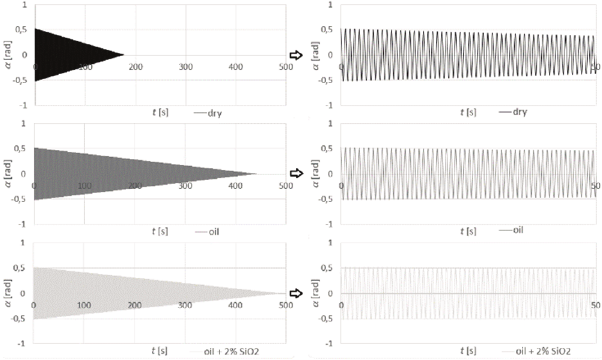
Fig. 5. The swinging angle a of the chain arranged as a physical pendulum against time t for different cases of friction in the contact zone between fixed chain pin and mating chain roller: dry, lubricated with pure engine oil and with engine oil containing 2wt % of SiO 2 nanoparticles. Courses on the right are the increased views for courses on the left side in the figure